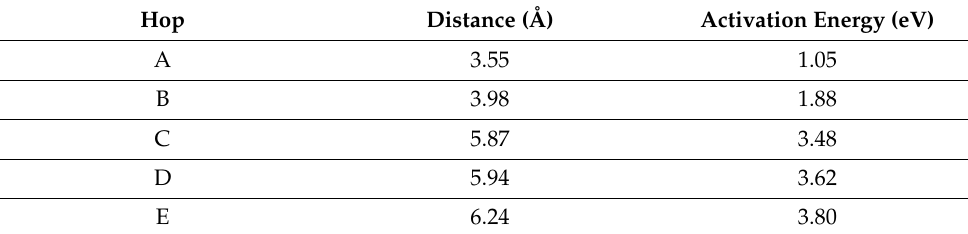
Table 4. Calculated activation energies of different Zn hops.